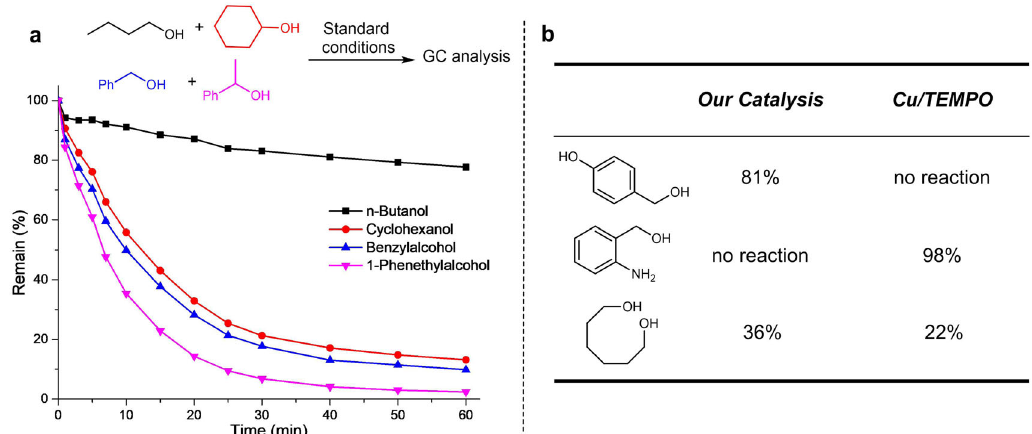
Fig. 4 Comparison of our catalyst system with Cu/TEMPO system. a Competition experiments monitored by GC analysis. Standard conditions: LaI 3 (0.004 mmol), o -Q (0.008 mmol), each alcohol substrates (0.1 mmol), MeCN (0.6 mL), room temperature, O 2 balloon. b Comparison of our catalyst system and Cu/TEMPO system.